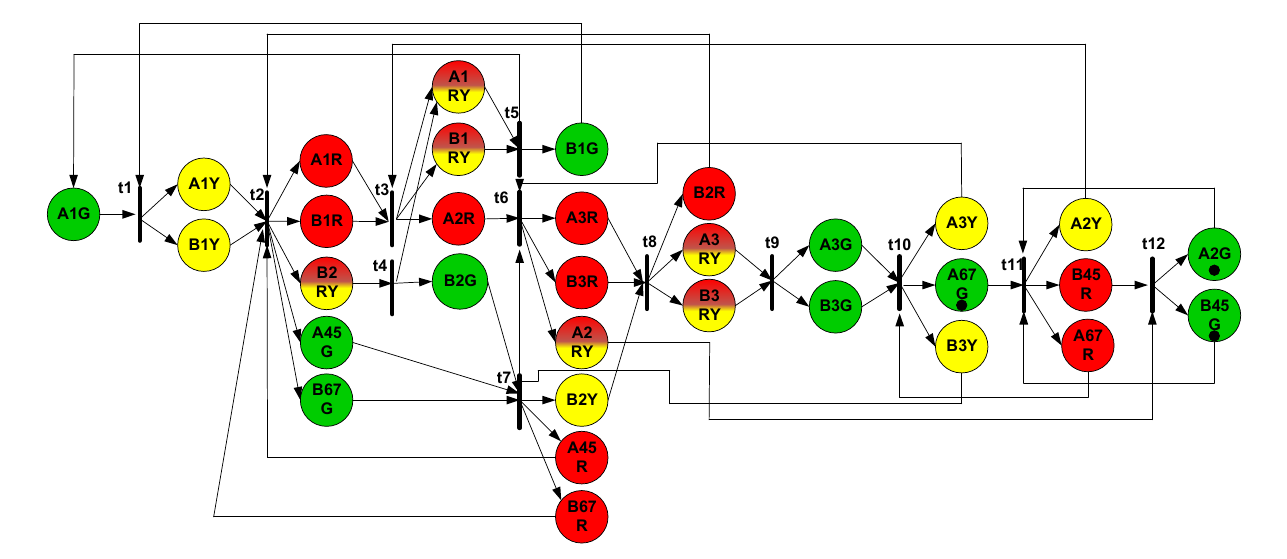
Figure 4. The initial specification of the crossroad traffic light system.